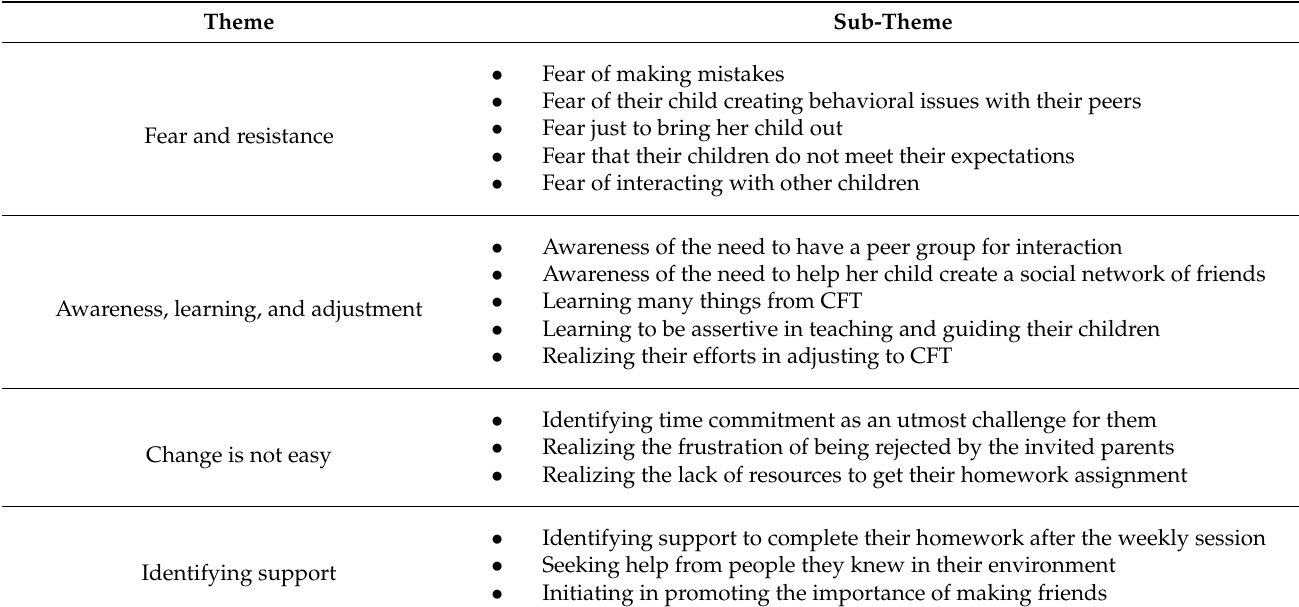
Table 5. Themes and subthemes from thematic analysis of parents’